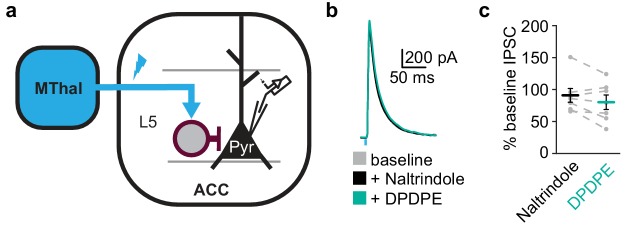
Opioid agonists induced suppression of inhibitory synaptic currents onto layer 5 pyramidal neurons in the ACC is mediated via delta-opioid receptors.(a) Experimental diagram in which ChR2(H134R) (blue) was injected in the MThal, and feed-forward GABAergic transmission (oIPSCs) was recorded from layer 5 (L5) pyramidal neurons (Pyr) in the ACC. (b) Example recordings of oIPSCs elicited from MThal terminals in the ACC during baseline (gray), in response to naltrindole (1 µM, black) and followed by DPDPE (1 µM, teal). Blue bar: 1 ms of 470 nm light stimulation. (c) Summary data of oIPSCs as described in a, plotted as percent of baseline (N = 3, n = 7), SM = 3.714, p = 0.156; Inaltrindole: 90.9± 10.8 % of baseline, IDPDPE: 80.1 ± 11.4 % of baseline; baseline vs. naltrindole, W(7) = 6, p = 0.219, naltrindole vs. DPDPE, W(7) = 7, p = 0.297. Skillings-Mack test followed by paired Wilcoxon signed-rank test post-hoc analysis. Mean ± standard error of the mean. SM: Skillings-Mack statistic.